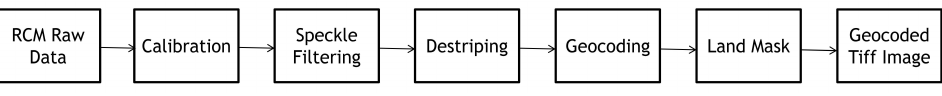
Figure 2. RCM preprocessing